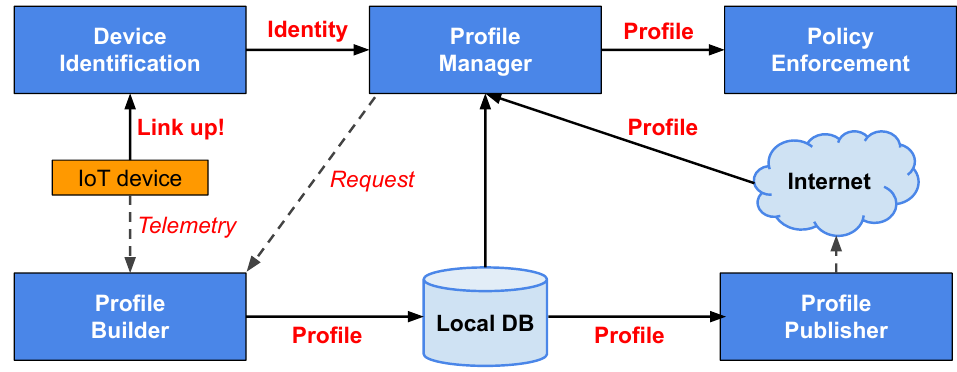
Figure 1. Overview of Autopolicy: function blocks (blue) and information flow (red).